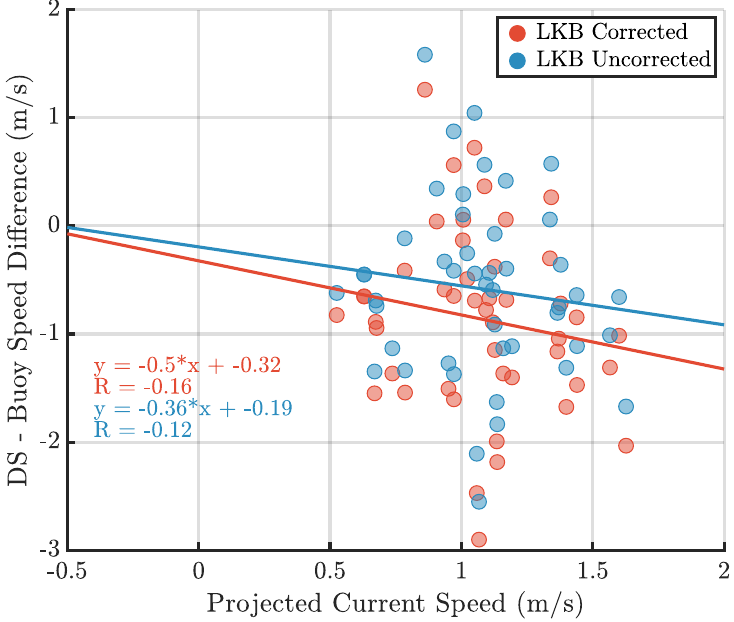
Figure 13. Difference between DopplerScatt measured and buoy measured wind speed plotted against wind direction-projected surface current